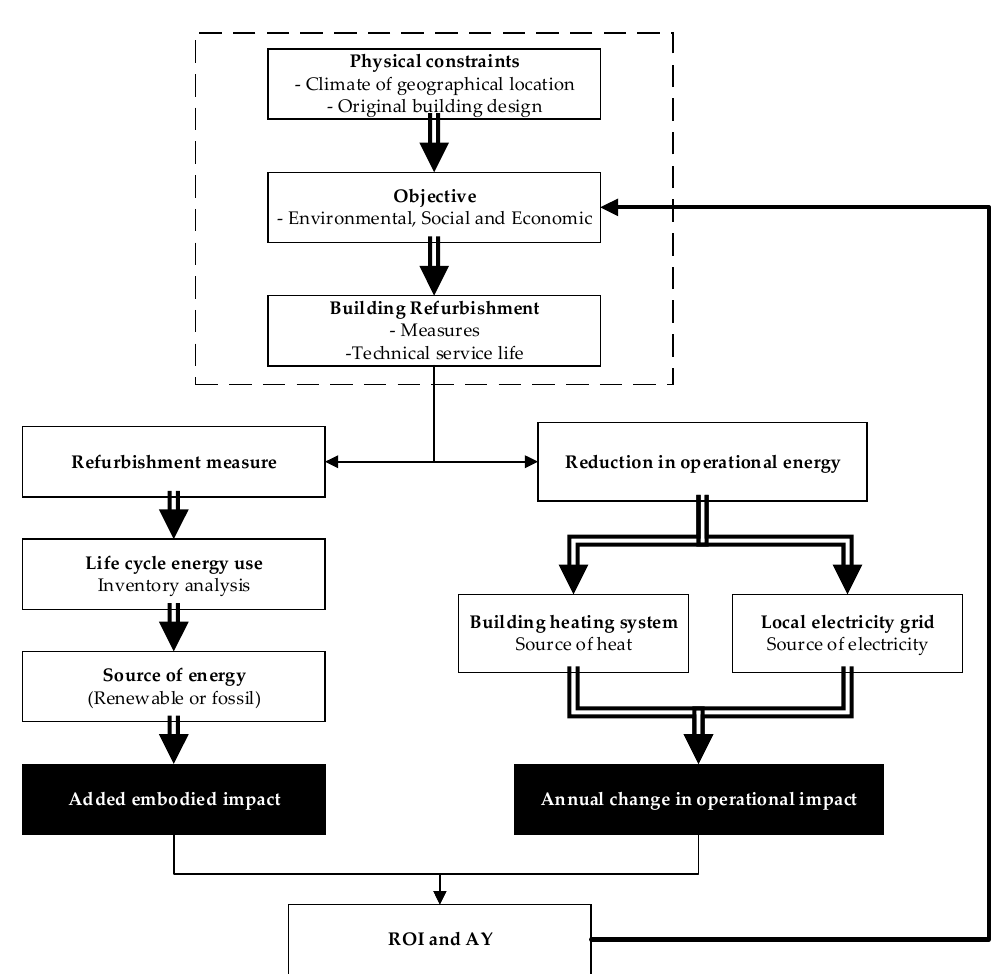
Figure 1. Process of estimating EPMs for building refurbishment.